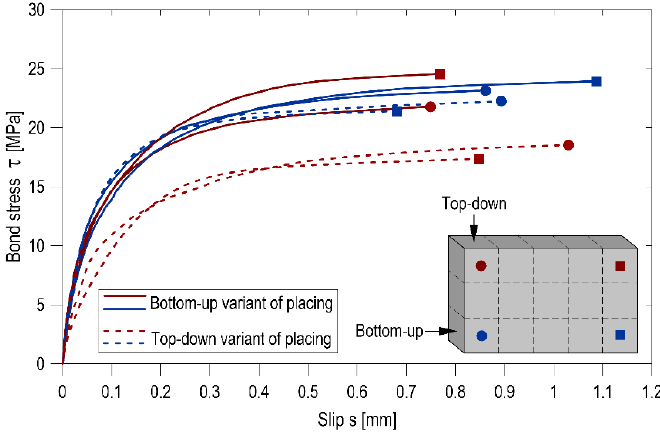
Figure 6. Bond stress vs. corresponding slip. Table 5. Respective bond stresses for the rebars in elements.